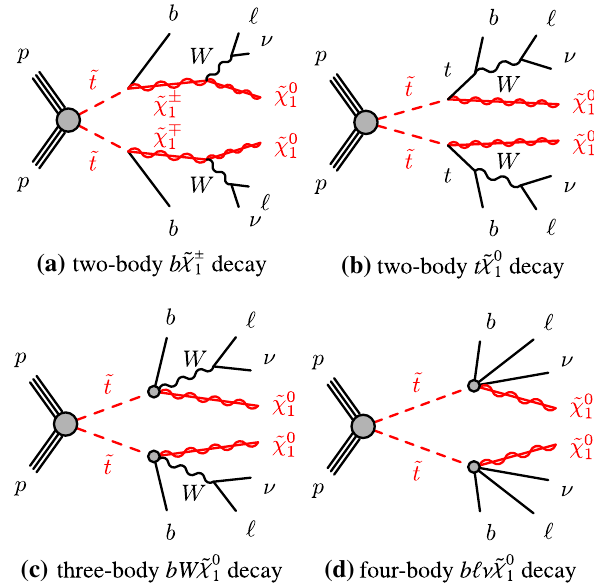
Fig. 1 Diagrams representing the four main signals targeted by the analyses: a the decay of the top squark via the lightest chargino ( ˜ t → ± b ˜ χ 1 ), b the two-body decay into an on-shell top quark and the lightest 0 neutralino ( ˜ t → t ˜ χ 1 ), c the three-body decay mode into an on-shell 0 W boson, a b -quark and the lightest neutralino ( ˜ t → bW ˜ χ 1 ) and d the (cid:4) ˜ χ 0 four-body decay mode ( ˜ t → bf f 1 ) where the two fermions f and (cid:4) f are a lepton with its neutrino in this article